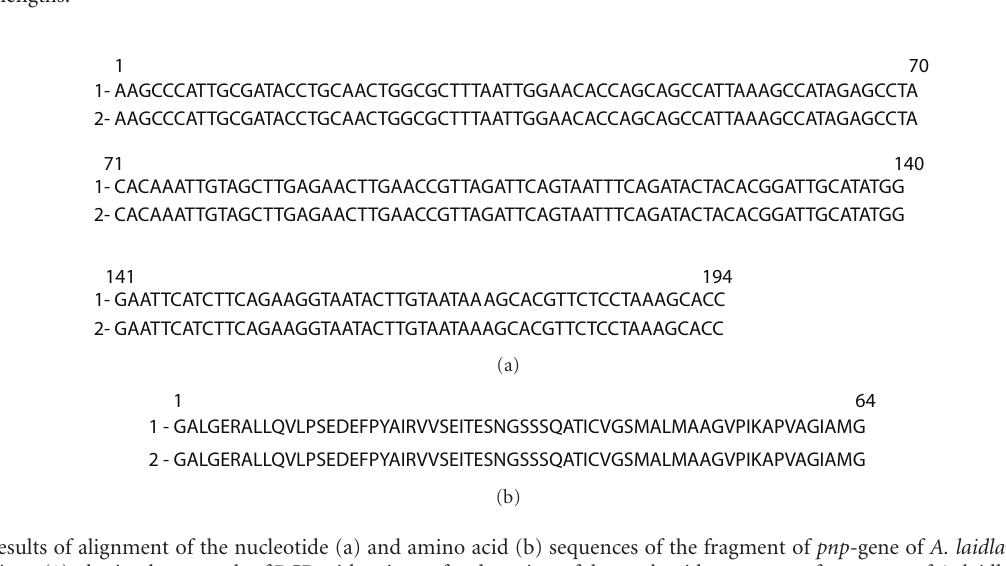
Figure 1: Electrophoregrams of amplification products for DNA nucleotide sequences of the following genes fts Z: (1, 7, 13, 19), pdh C (2, 8, 15, 20), pnp (3, 9, 16, 21), tuf B (4, 10, 17, 22), rpo B (5, 11, 18, 23), and 16S–23S rRNA (6, 12, 14, 24) A. laidlawii PG8 obtained at use, in PCR, total DNA (as matrix) isolated from cells of A. laidlawii PG8 (a) and plant leaves grown in medium with the mycoplasma cells (b and c—2 h and 9 days, resp.) and in the absence of the infect (d). Arrow indicates location of the corresponding PCR-signal. M—a marker of fragment lengths.